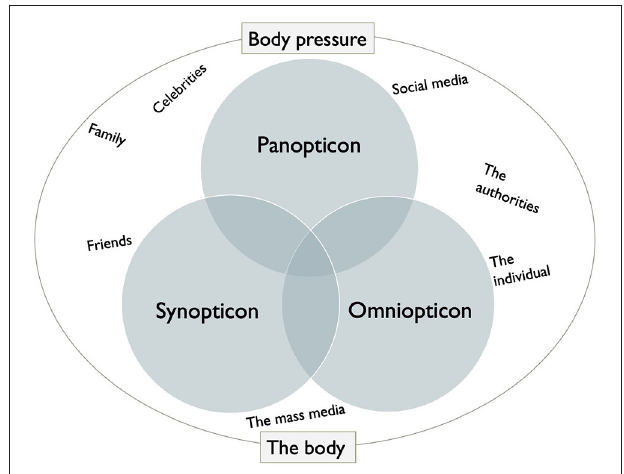
FIGURE 1 | The BOPS model. Various sources of influence regarding body image and body pressure among young people.